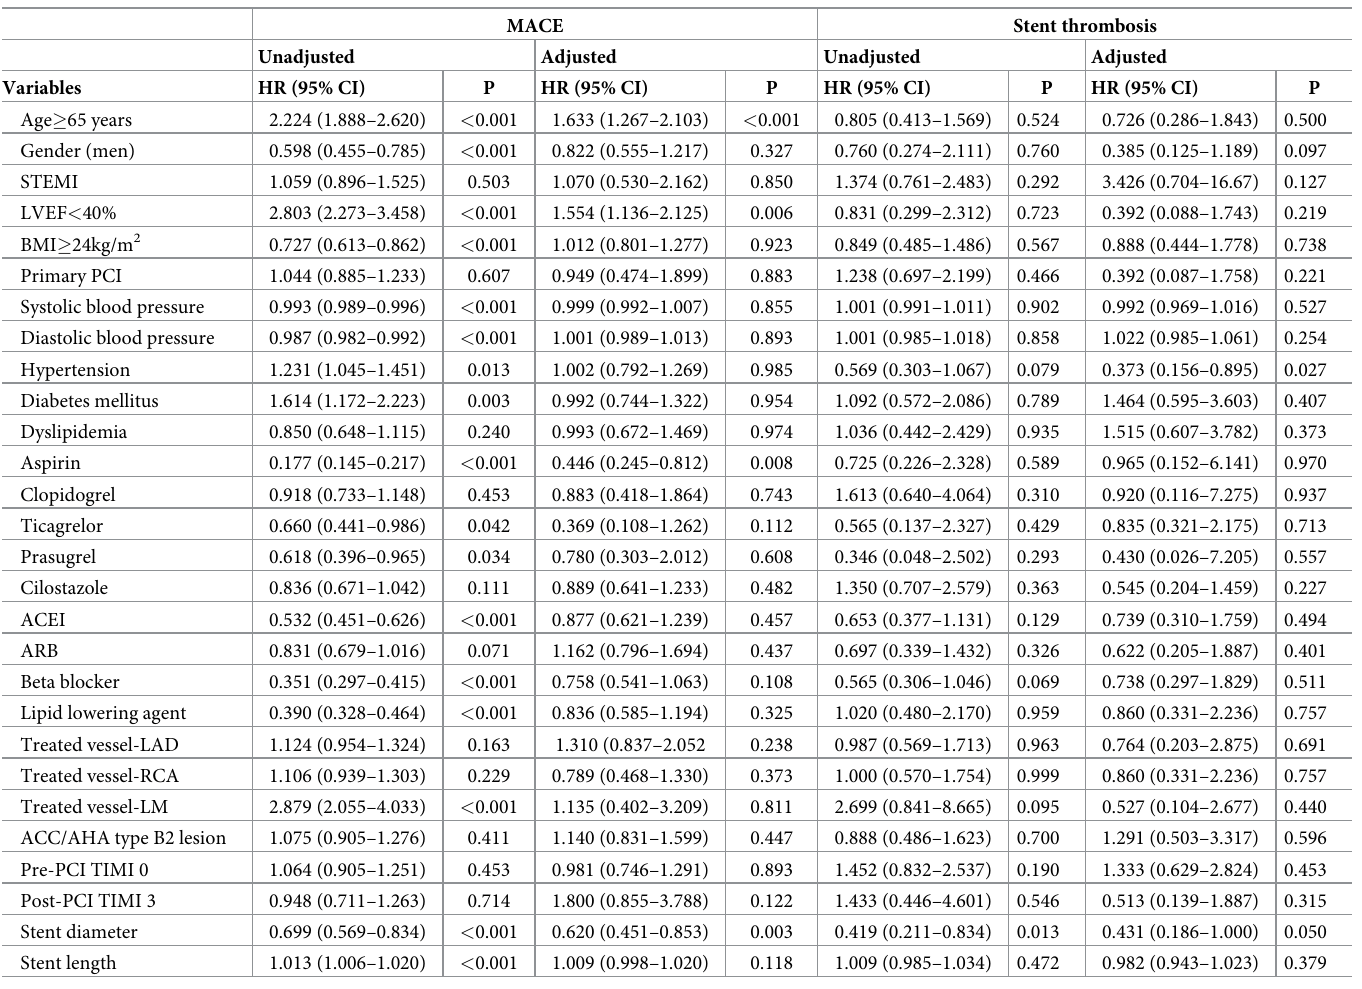
Table 4. Independent predictors for MACE and stent thrombosis at 2